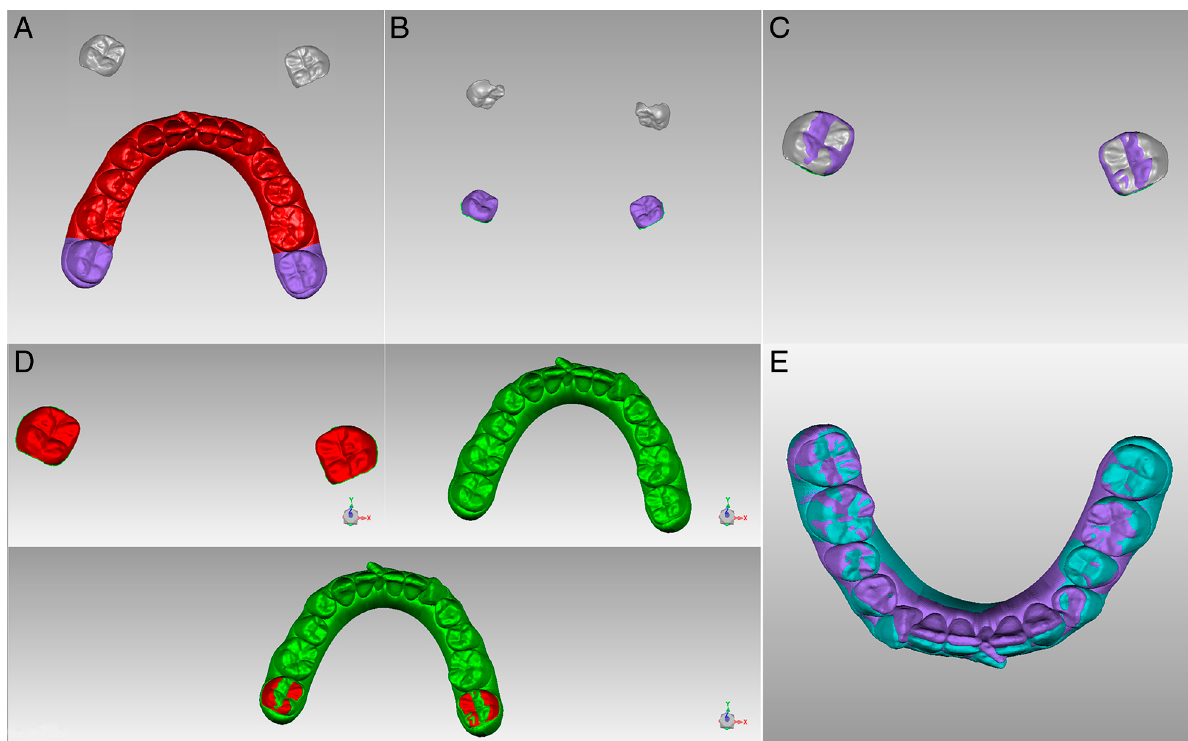
Figure 2. Superimposition of the initial models and progress models based on the stable structure method (unmoved teeth in the ClinCheck) using the GEOMAGIC studio software. (a) Teeth designed not to be moved in ClinCheck were respectively separated from initial models and progress models (grey and purple coloured the second molars); (b) and (c) Registration of the unmoved teeth (second molars); (d) and (e) Final superimposition using the unmoved teeth (second molars) as